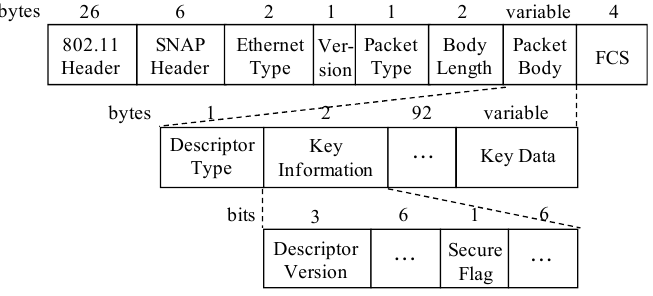
Figure 6. Format of the QoS Data frame with the EAPOL-Key message.